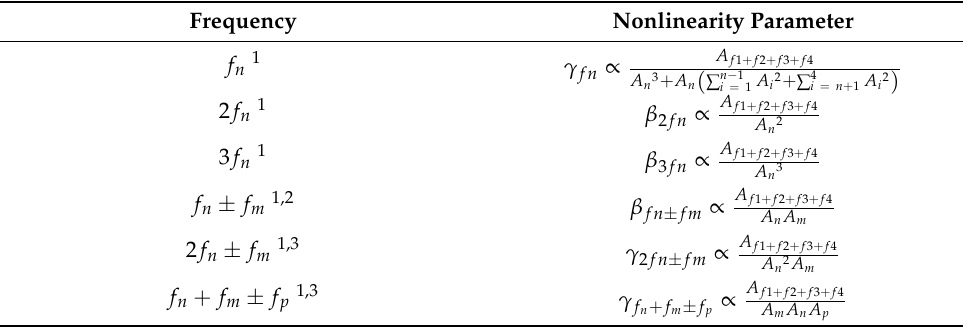
Table 1. Nonlinearity parameter of